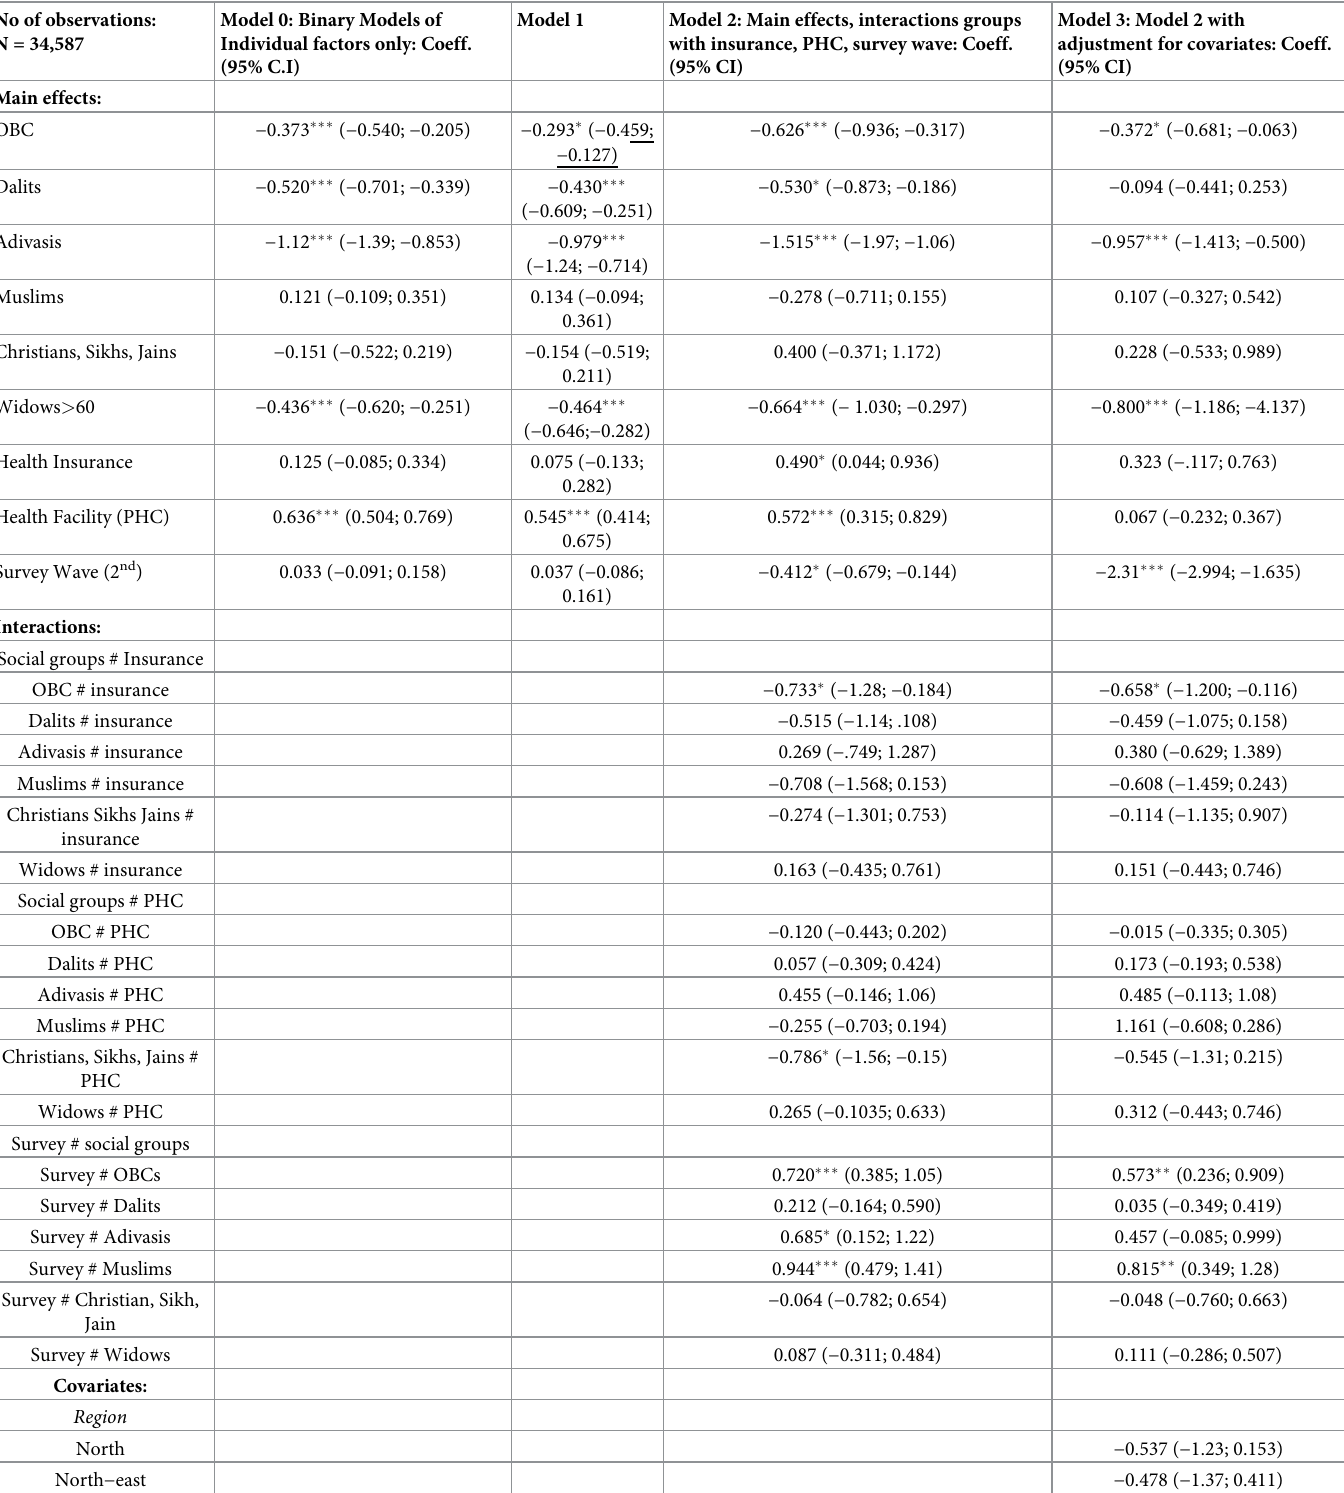
Table 3. Multilevel mixed effects models of treatment seeking.